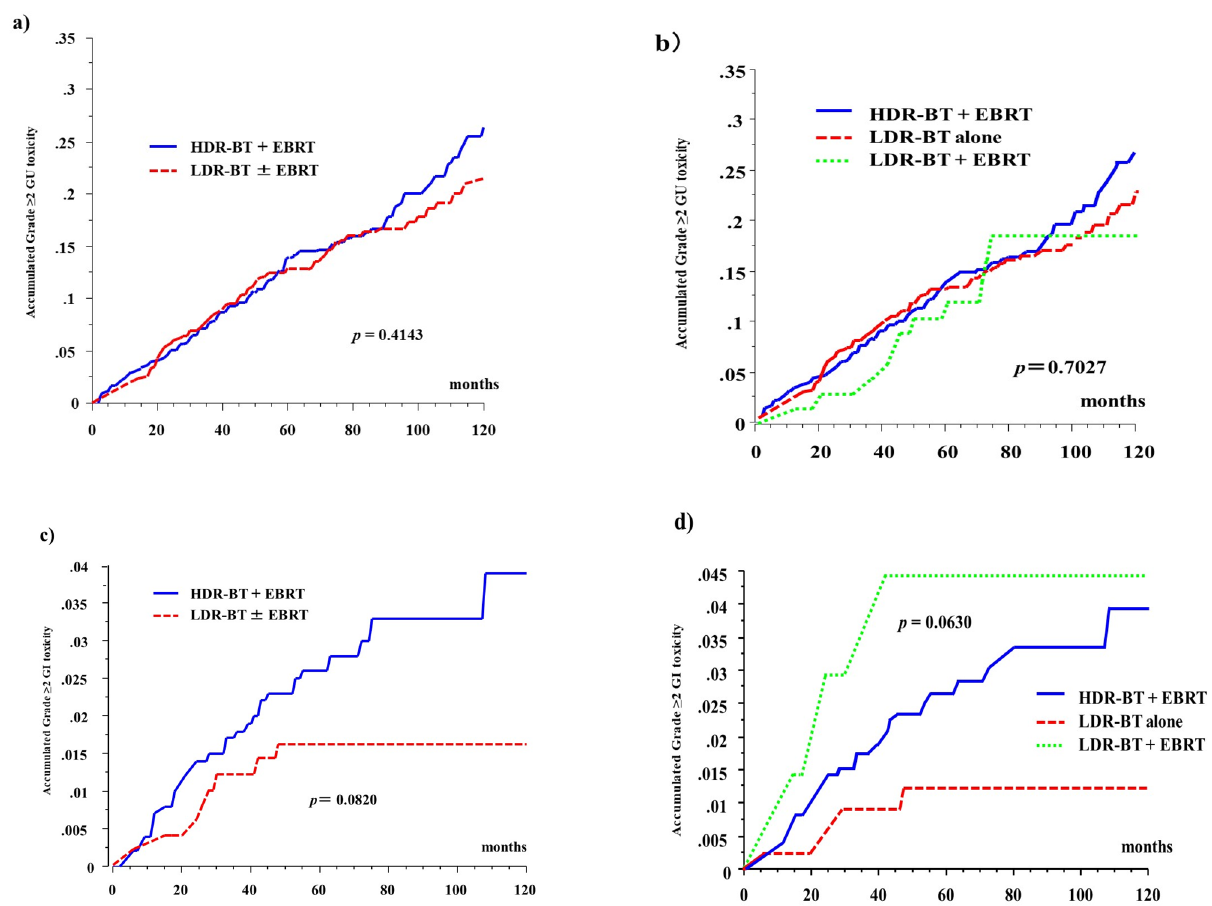
Figure 5. Accumulated incidence of grade ≥ 2 toxicity. ( a ) Accumulated incidence of grade ≥ 2 Genitourinary (GU) toxicity between HDR-BT with EBRT and LDR-BT with or without EBRT. ( b ) Accumulated incidence of grade ≥ 2 GU toxicity among three group. (HDR-BT with EBRT vs. LDR-BT alone vs. LDR-BT with EBRT). ( c ) Accumulated incidence of grade ≥ 2 Gastrointestinal (GI) toxicity between HDR-BT with EBRT and LDR-BT with or without EBRT. ( d ) Accumulated incidence of grade ≥ 2 GI toxicity among three group. (HDR-BT with EBRT vs. LDR-BT alone vs. LDR-BT with EBRT).